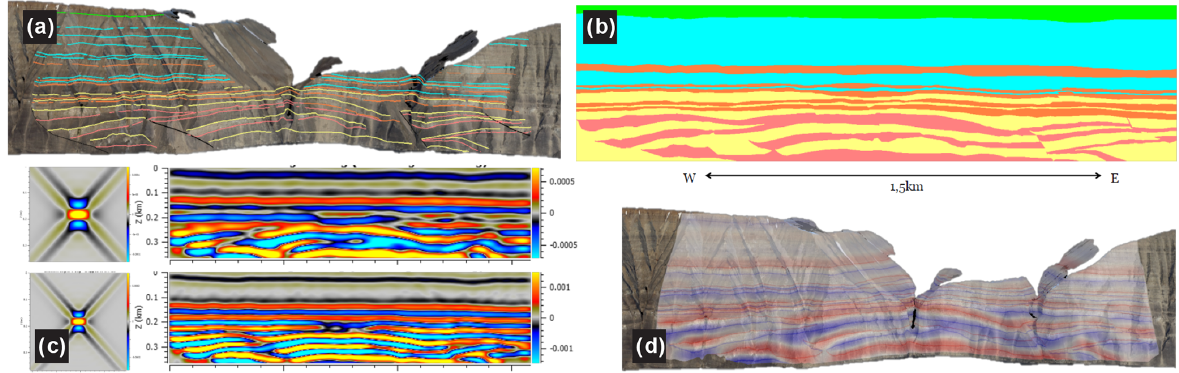
Figure 7. Examples from seismic modelling of the Kvalpynten digital outcrop model (https://v3geo.com/model/90, last access: 7 September 2021) conducted by the 2019 AG222 class on a ca. 2km long part of the outcrop. (a) Interpretation of digital outcrop model using LIME. (b) Assignment of elastic parameters to specific lithologies. (c) Seismic modelling under varying dominant frequencies using SeisRoX. (d) Direct overlay of the seismic model on the DOM.